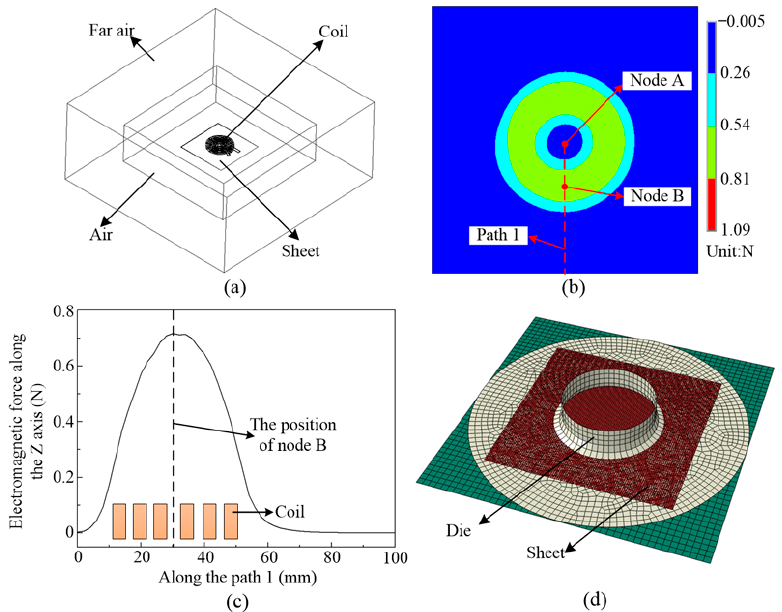
Figure 8. Finite element model of electromagnetic forming: ( a ) electromagnetic field model; ( b ) contours of magnetic force distribution; ( c ) magnetic force along Path 1; ( d ) structure field.